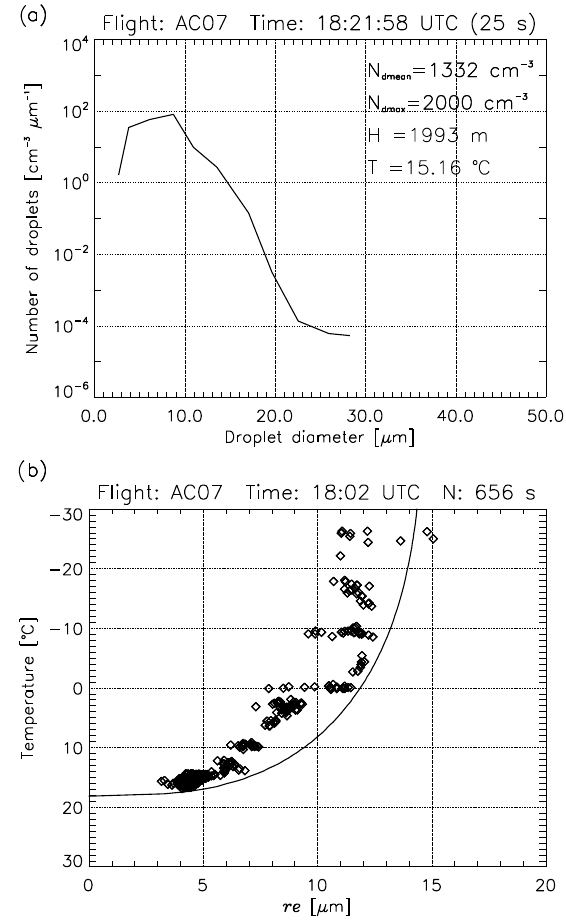
Figure 4. (a) Mean cloud droplet size distribution calculated from the CCP–CDP data for a cloud pass at cloud base during flight AC07. The flight number, initial time of cloud pass, and duration in seconds are shown at the top of graph. The mean total num- ber of droplets ( N dmean ) , the maximum total number of droplets ( N dmax ) in 1s for this cloud pass, and the approximate height ( H ) and temperature ( T ) are shown at the upper right corner of the graph; (b) cloud droplet effective radius ( r e ) calculated from CCP– CDP as a function of temperature is indicated with dots. The black line indicates the estimated adiabatic effective radius ( r ea ) as a func- tion of